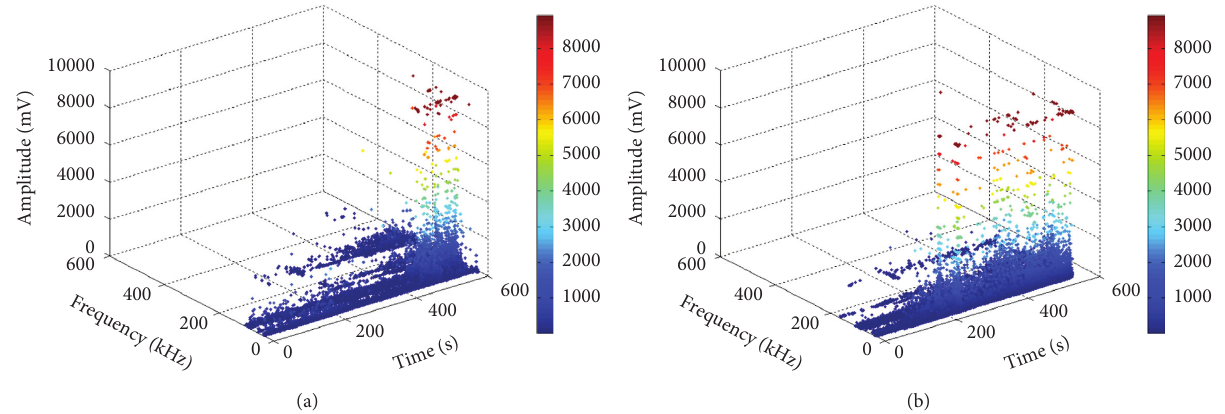
Figure 11: Three-dimensional distribution of the AE frequency-time-amplitude of the intact specimen (a) and the intact specimen containing an opening